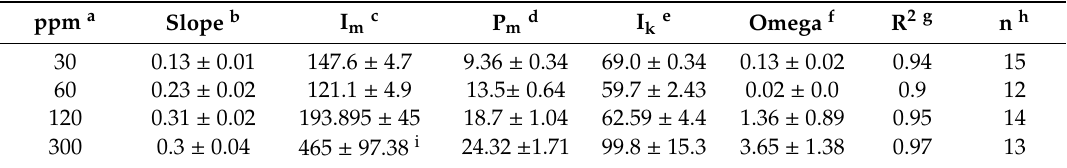
Table 1. Photosynthetic performance parameters extracted from a logarithmic curve and fitted to the ETR index